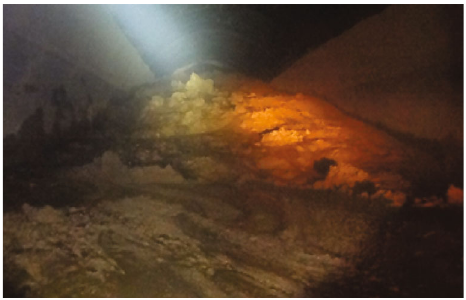
Figure 5: Gush of muddy fi llings in F2 fault of Yonglian